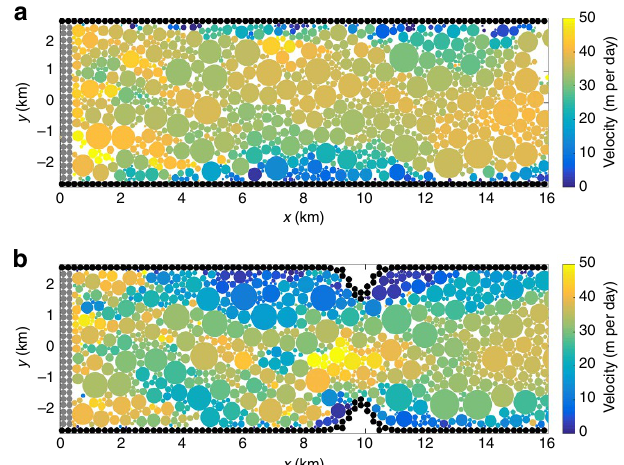
Figure 1 | Snapshots of iceberg positions and velocities in two different channel configurations. Both snapshots are 11 days into simulations with steady terminus advance and no calving, with 2-m-thick sea ice bonds, which are not plotted here. Velocity of each iceberg element is indicated by filled colour. Terminus elements are filled grey circles. Channel sides are filled black circles. ( a ) Straight channel configuration. ( b ) Narrowed channel Table 1 | Parameters used in this study.